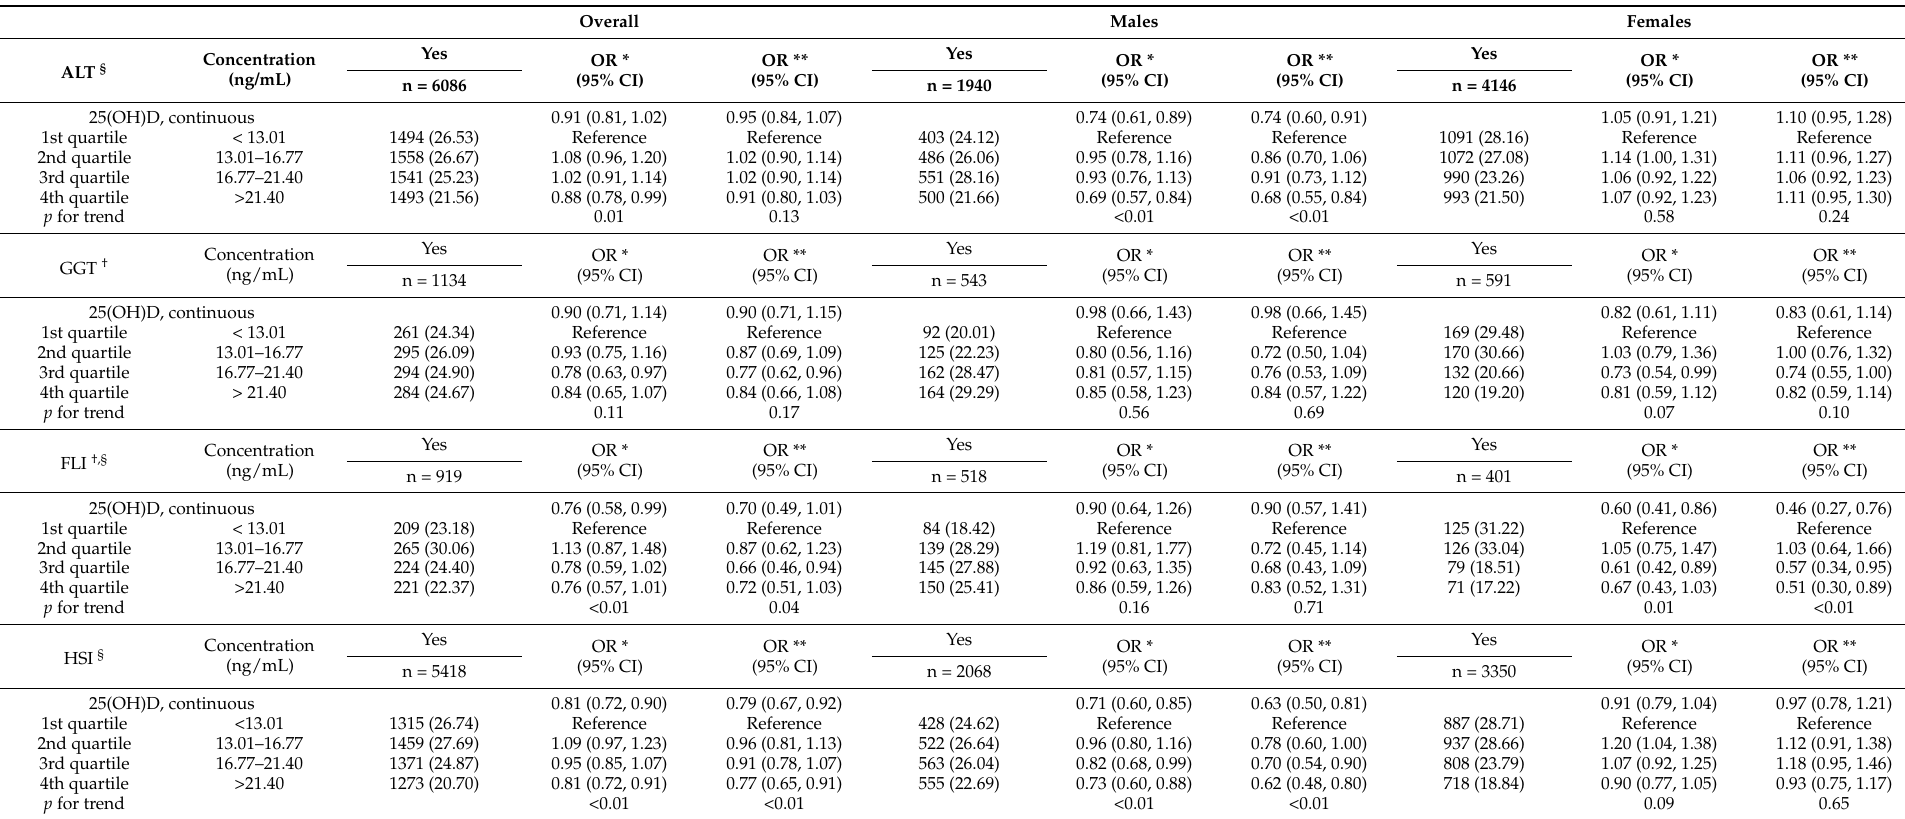
Table 3. Association between serum 25(OH)D levels, elevated serum liver enzymes, and NAFLD indices. Overall Males